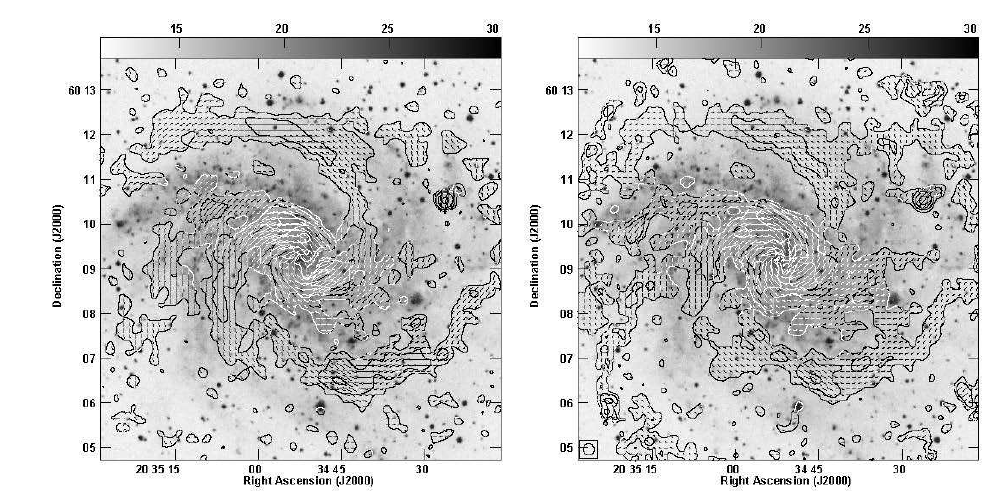
Figure 2. Polarized intensity and magnetic field maps of NGC6946 obtained by rotating the observed polarization maps by 90 ◦ and by overlaying them on a black-and-white image from the 2nd digitized sky survey blue (DSS2 B; McLean et al. [23]). Left : C-band map. The contour intervals are (3, 6, 12, 24, 48 and 96) × 20 µ Jy/beam. Right : X-band map. The contour intervals are (3, 6, 12, 24, 48 and 96) × 13 µ Jy/beam.